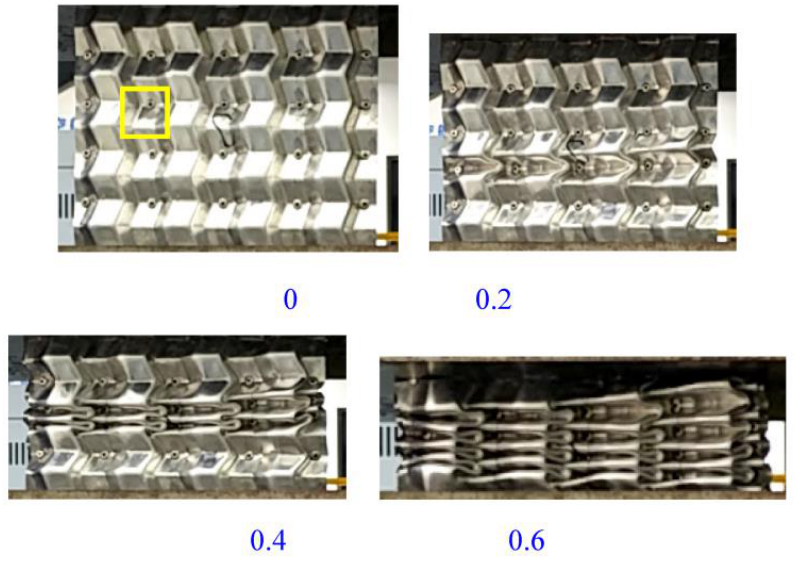
Figure 6. Schematic diagram of the axial compression process of origami honeycomb 3.